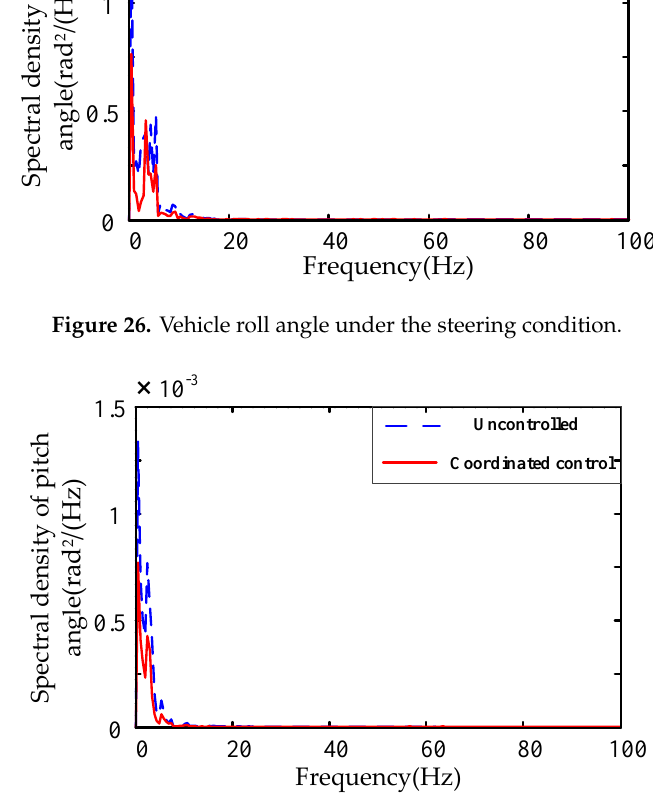
Figure 27. Vehicle pitch angle under the steering condition.